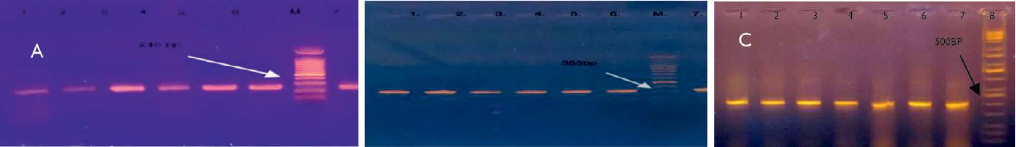
Fig. 2. Agarose gel electrophoresis (1% agarose, 7 v/cm 2 ) and Ethidium bromide staining to detect A: 16S rRNA gene size product (band 240bp); B: OXA51 gene size product (band 353bp) c- rec A gene .using template DNA prepared by boiling method. Right, Lane, molecular size DNA ladder (100 bp DNA Ladder); Left lanes DNAs isolated from A.baumannii sample showed Positive PCR.